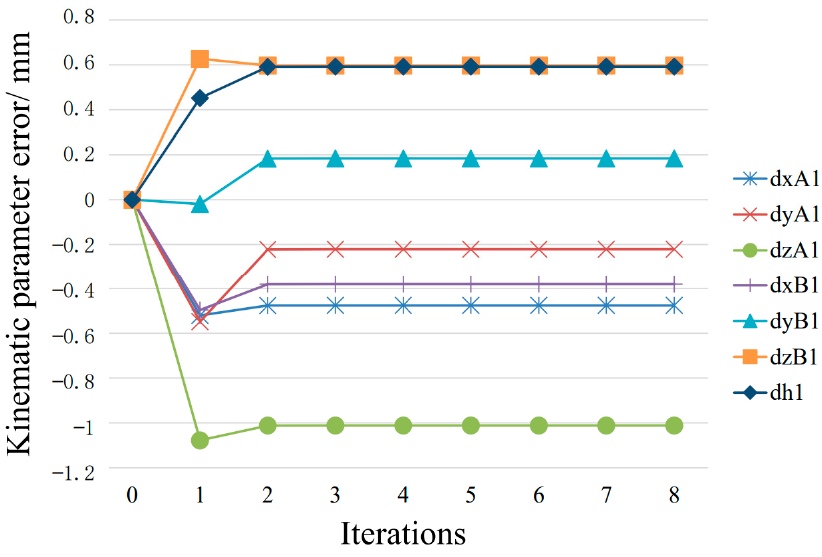
Figure 8. The variation of kinematic parameter errors during the calibration.